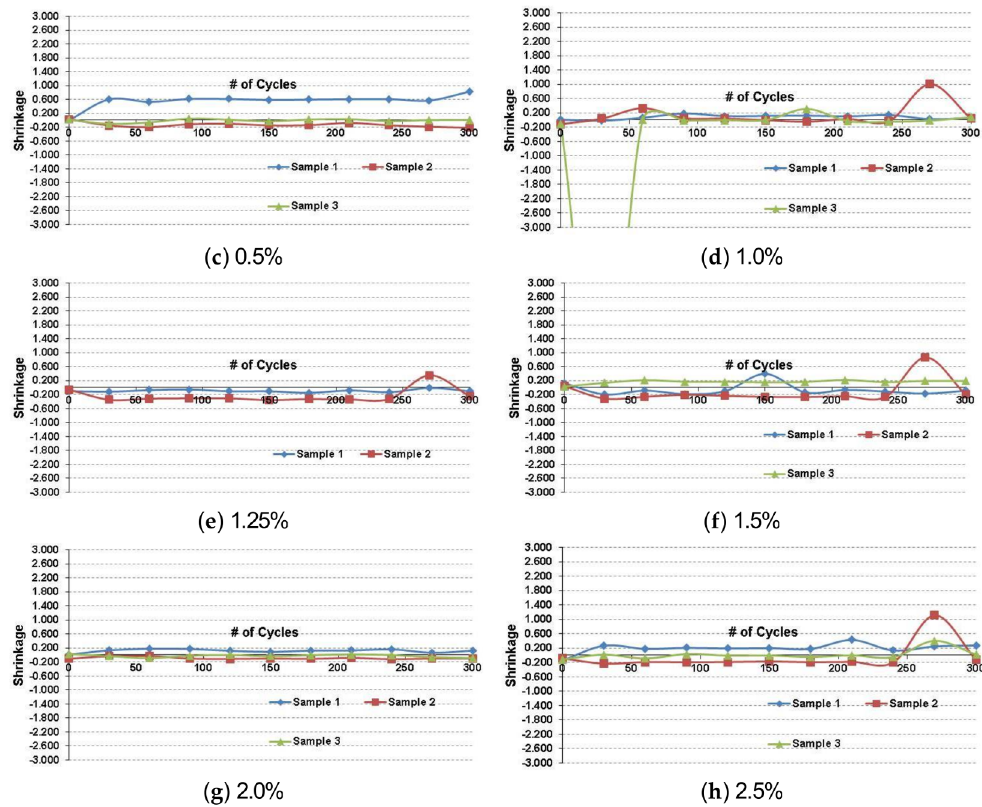
Figure 11. Shrinkage results due to thermal fatigue